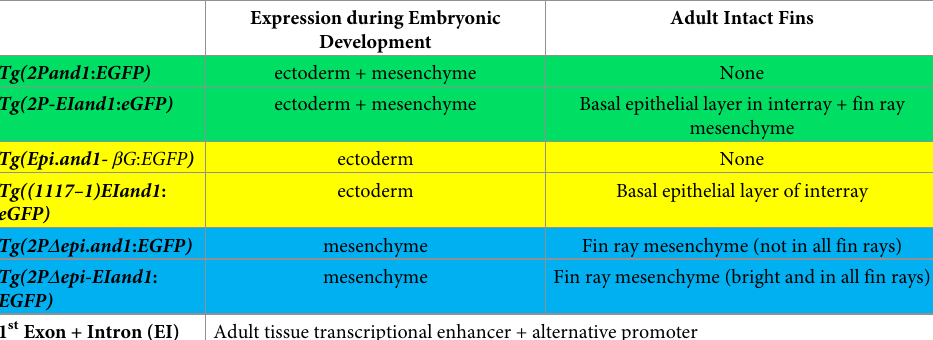
Table 1. Change in expression of several and1 reporter lines towards